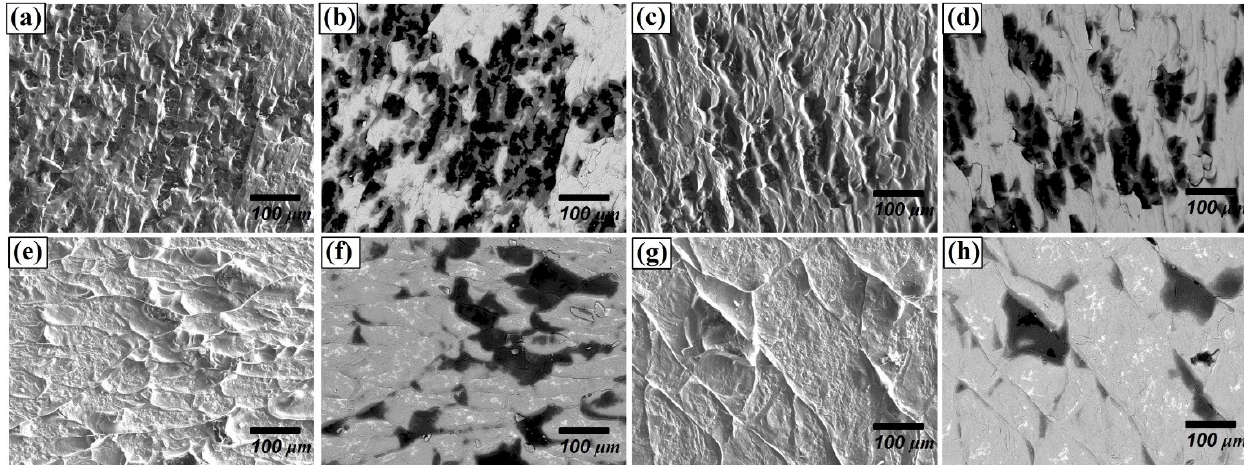
Figure 8. Fracture surface of F82H–Be joint at 1023 K for ( a , b ) 30 min, ( c , d ) 60 min, ( e , f ) 90 m, and ( g , h ) 1123 K for 90 min, ( a , c , e , g : secondary electron images, b , d , f , h : backscattered electron images).